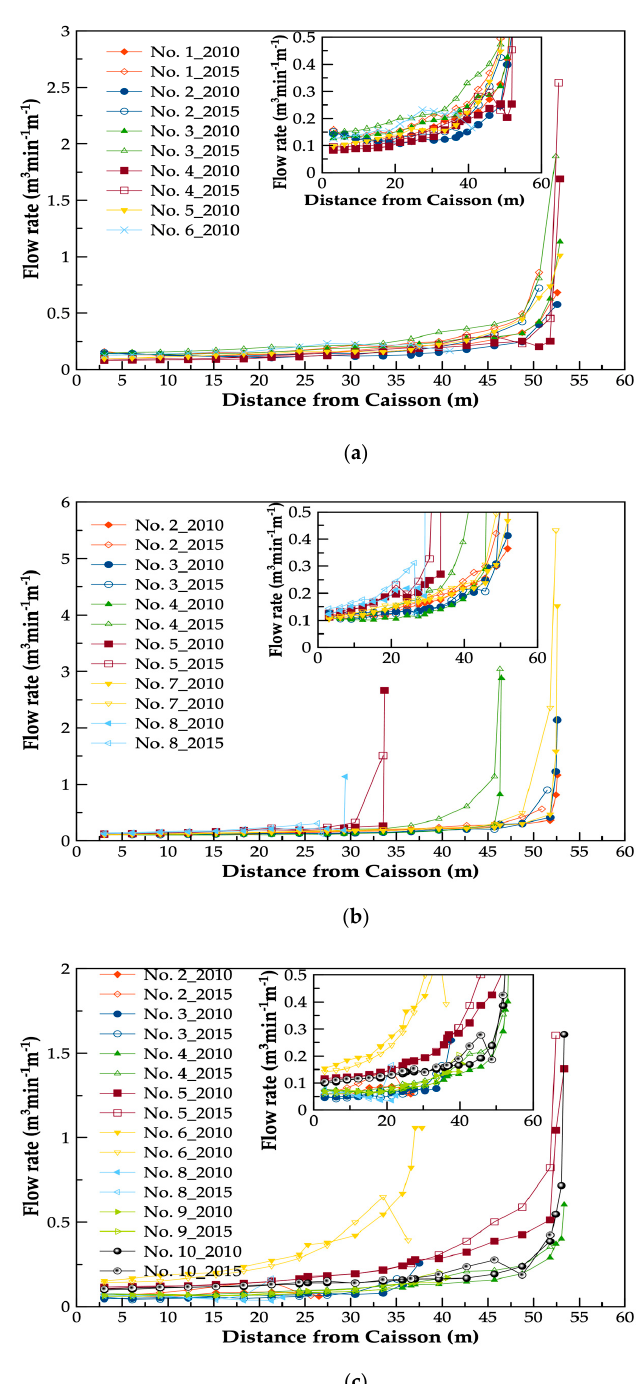
Figure 6. Flow along different laterals at increasing distances between the screen length and the caisson for ( a ) Collector 3, ( b ) Collector 4, and ( c ) Collector